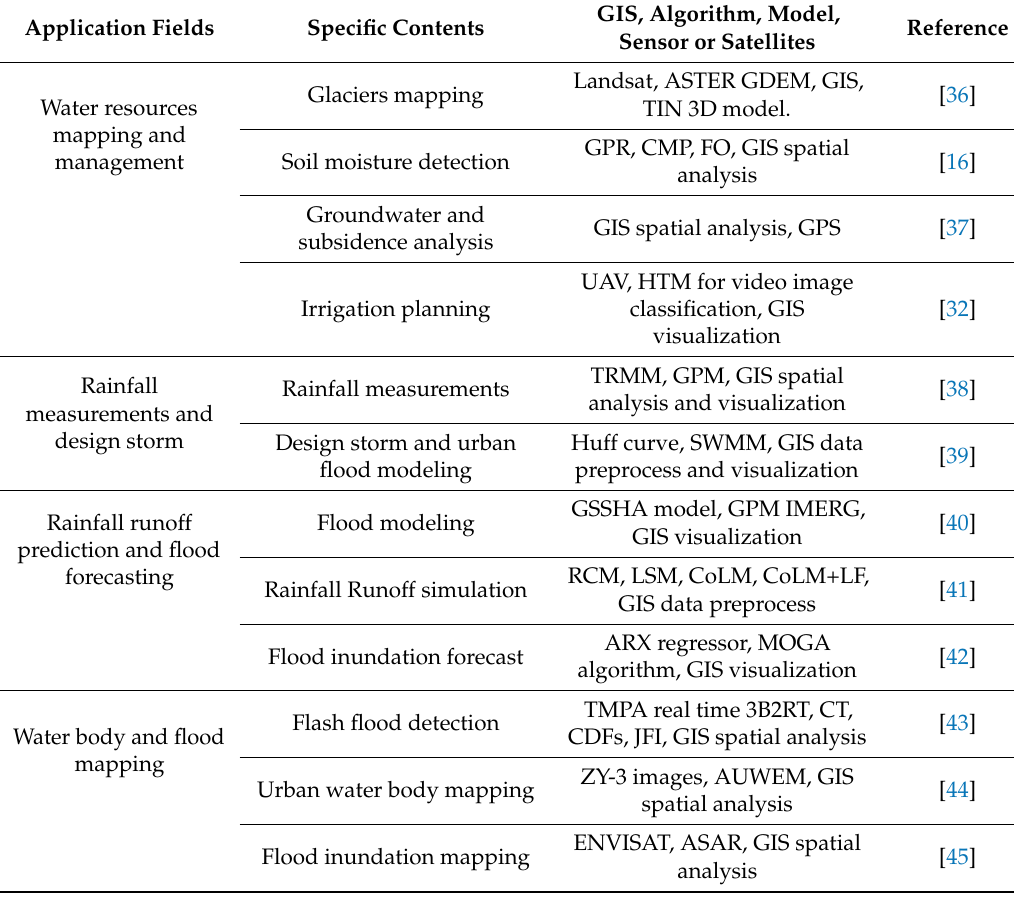
Table 2. Latest geographic information systems (GIS) and remote sensing technologies and hydrologic models applied in the 12 papers published in this special